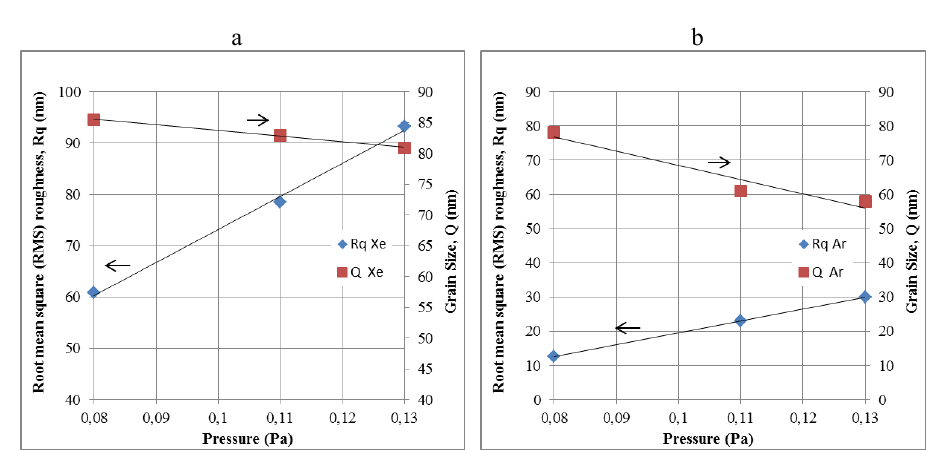
Fig. 4. Plots of roughness (Rq) and grain size (Q) dependencies on the pressure of the working gas mixture with (Xe + CO 2 ) (a) and (Ar + CO 2 ) (b).